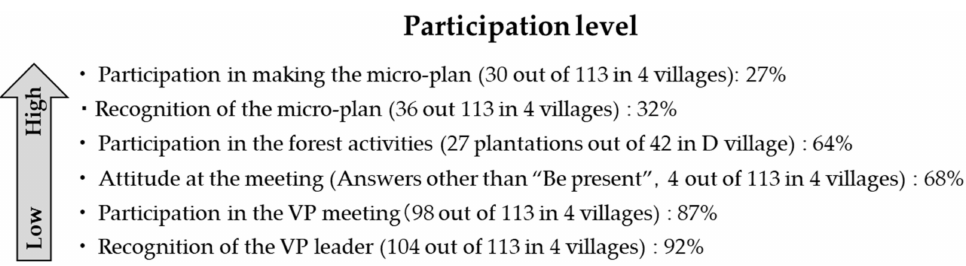
Figure 5. Level of participation. Source: based on the results of a structured interview of households.